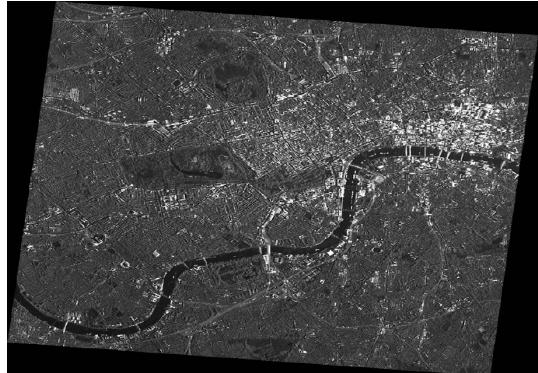
Figure 2. X-SAR Enhanced spotlight of Hyde